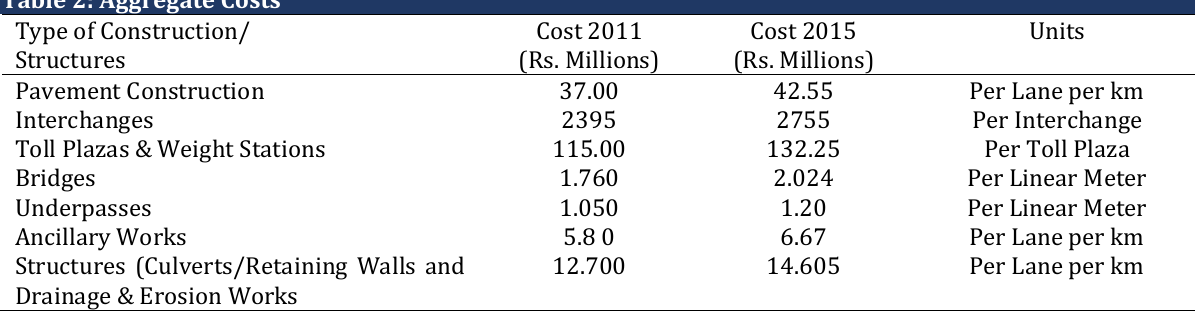
Table 2: Aggregate Costs